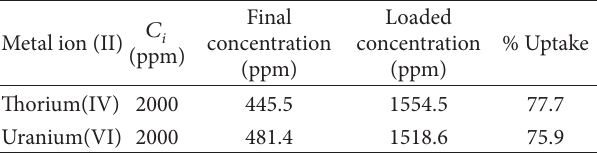
T 10: Metal ion uptake using column experiment at pH =